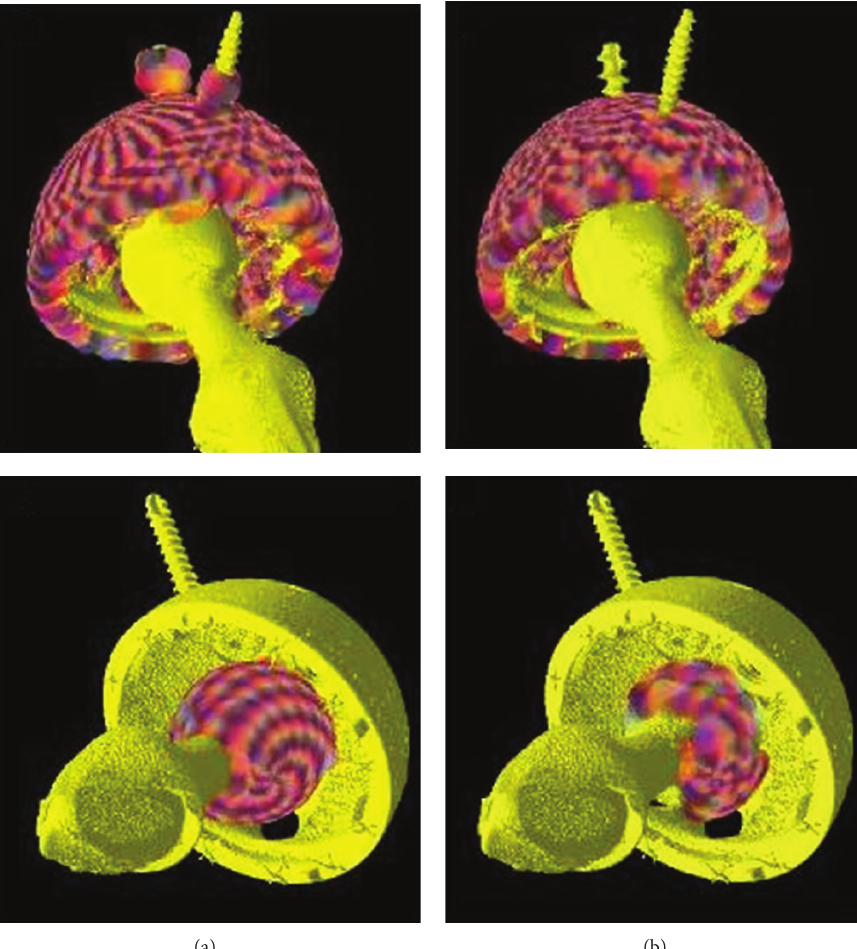
Figure 4: The top row illustrates the initial and valid surface landmarks produced on the acetabular cup by the surface extraction algorithm and the bottom row shows those for the femoral component head. The set of initial landmarks produced is shown in (a). The set of valid landmarks is shown in (b). The overlapping colored spherical glyphs represent the generated landmarks.